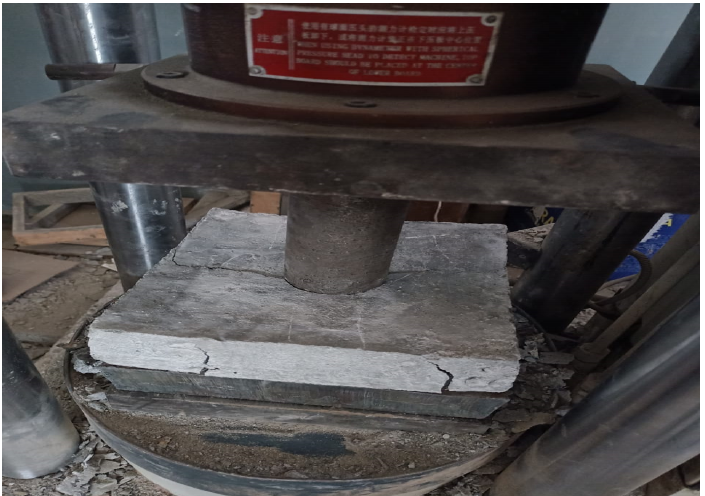
Figure 3. Punching strength setup.